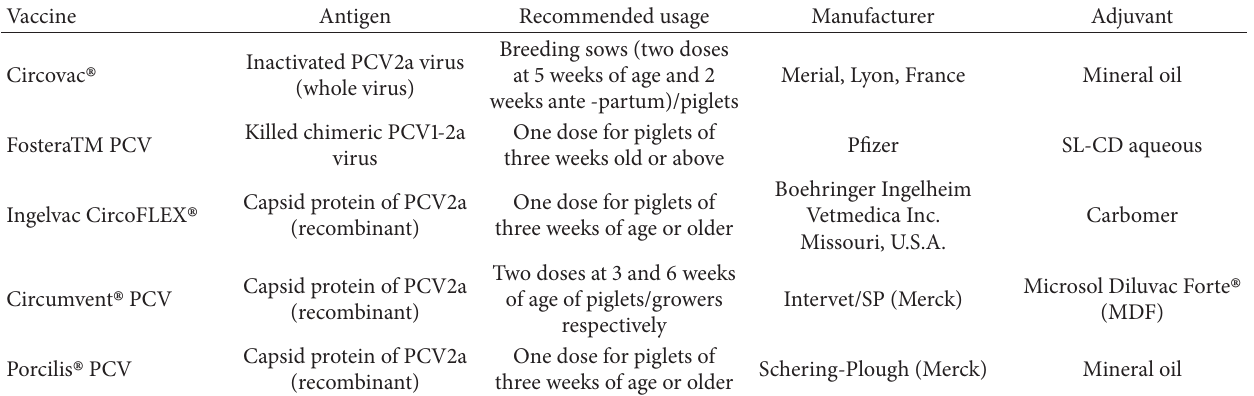
Table 2: Available commercial PCV2 vaccines and some of their